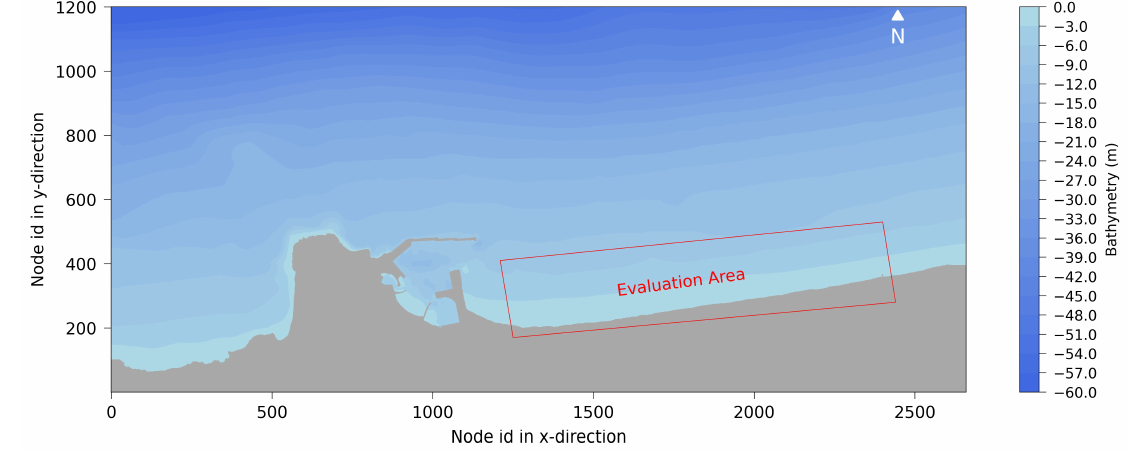
Figure 4. Bathymetry of the study area in Rethymno, Crete, Greece.